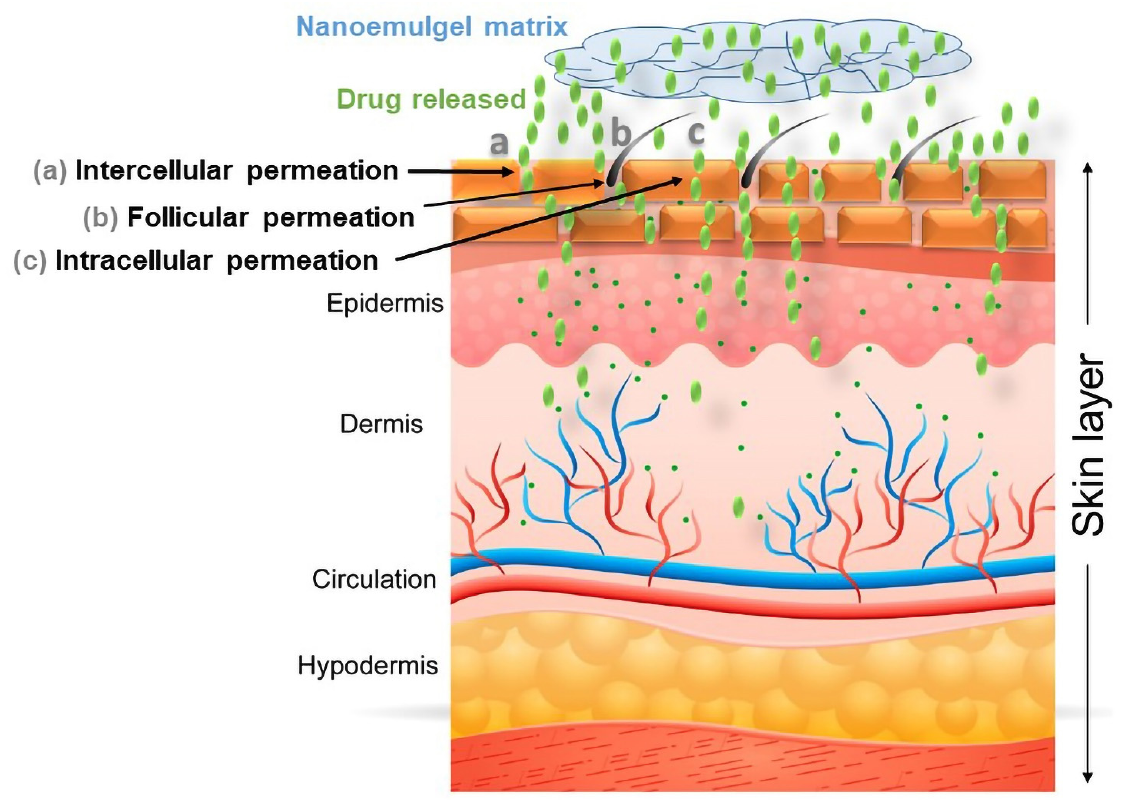
Figure 5. Illustration highlights the improved permeation of the bioactive compound (through intercellular, follicular, and intracellular permeation) to the deeper layer of skin utilizing a nanoemulgel system as a delivery vehicle.